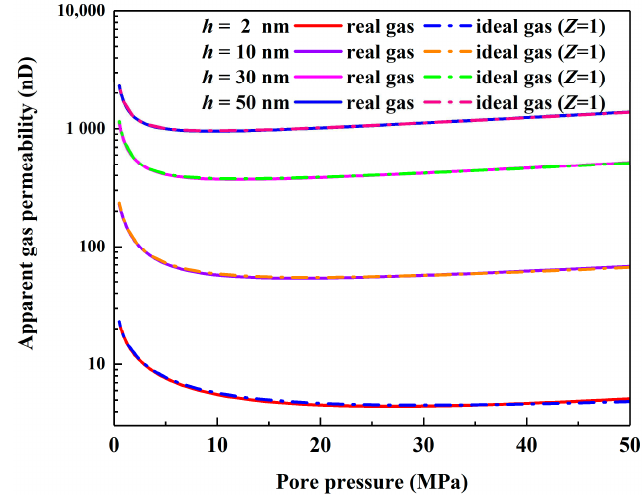
Figure 10. AGP in inorganic pore varies with pressure at different radius ( S w = 0.1).